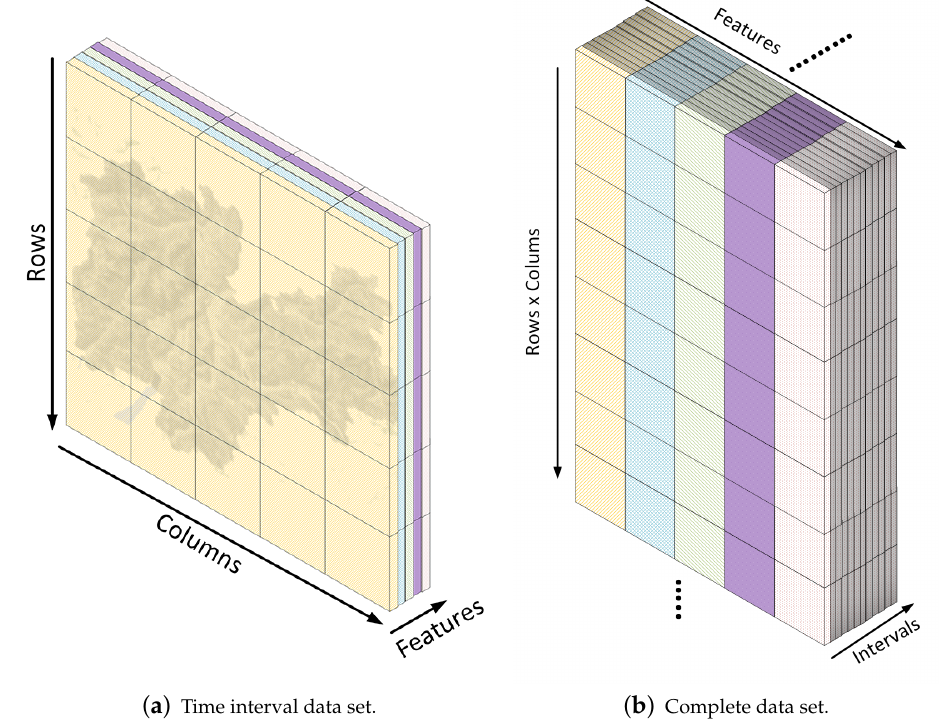
Figure 1. Panel ( a ) depicts a graphical representation of a three-dimensional data cube of the Trento province data set, where one dimension covers the set of network characteristics in each cell located by the other dimensions which represent the geographic information. Panel ( b ) represents the complete data set as a three-dimensional data cube, where it is represented each reshaped time